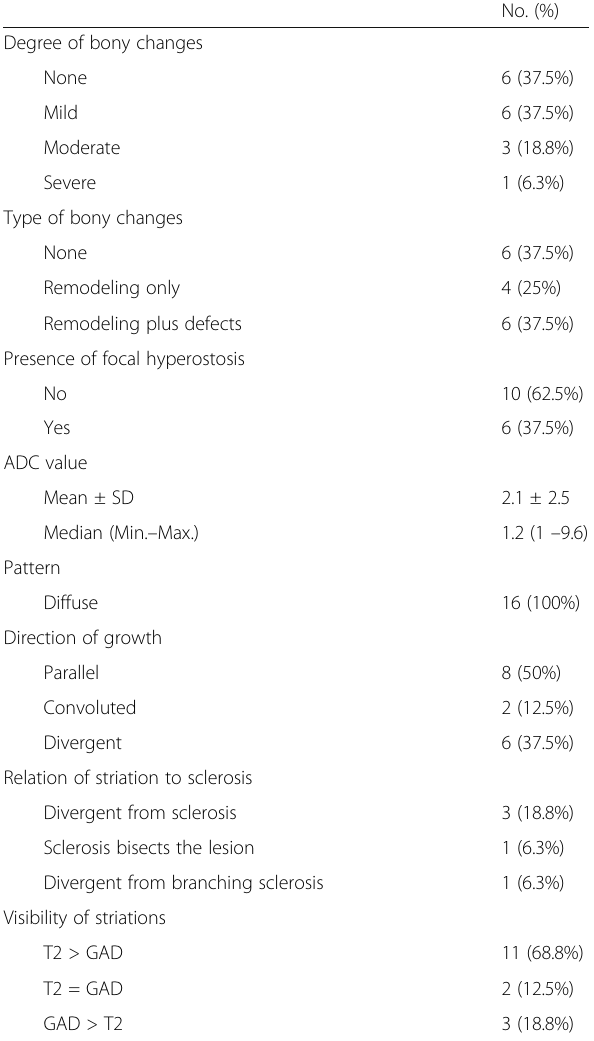
Table 5 Distribution of the studied cases according to different parameters ( n =